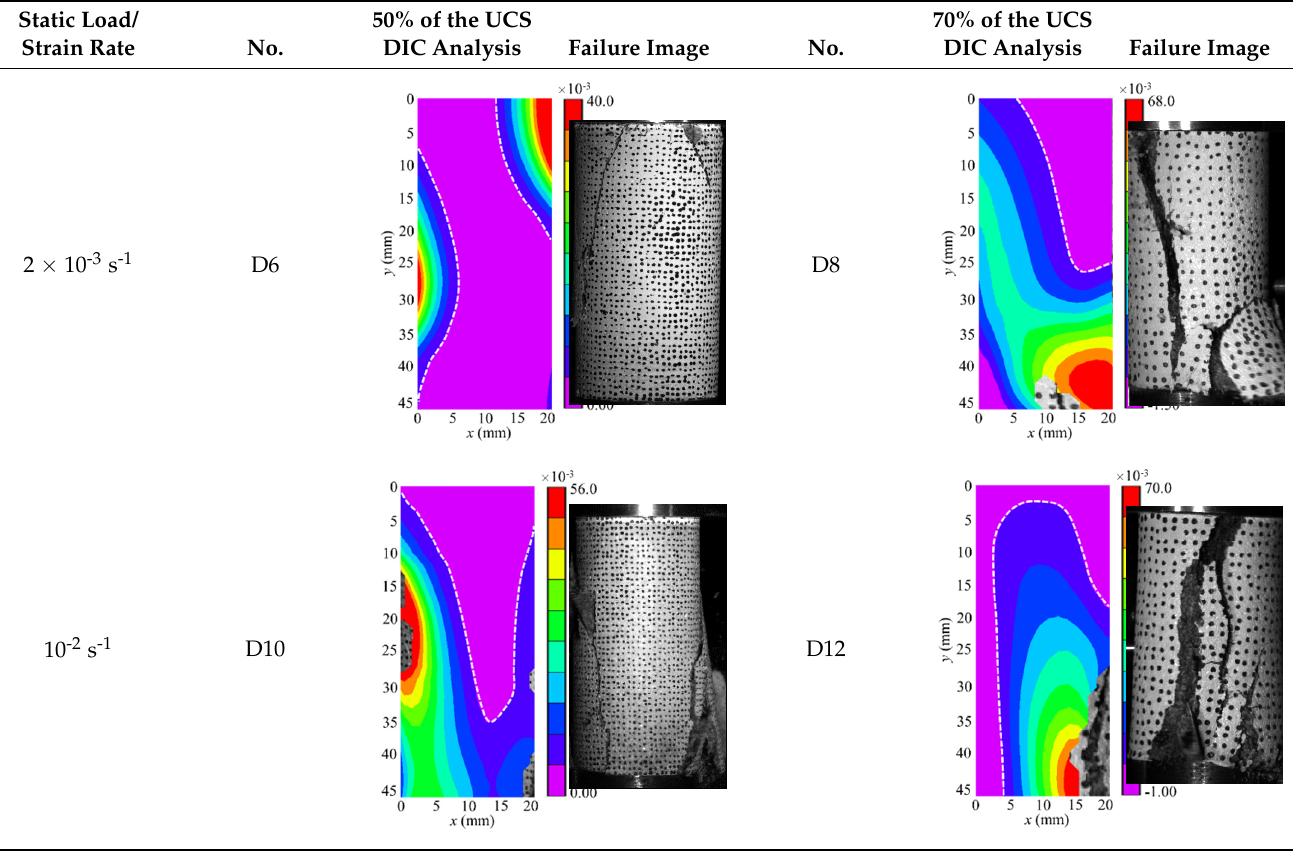
Table 4. The failure patterns of rock specimens under superimposed static and dynamic loads.